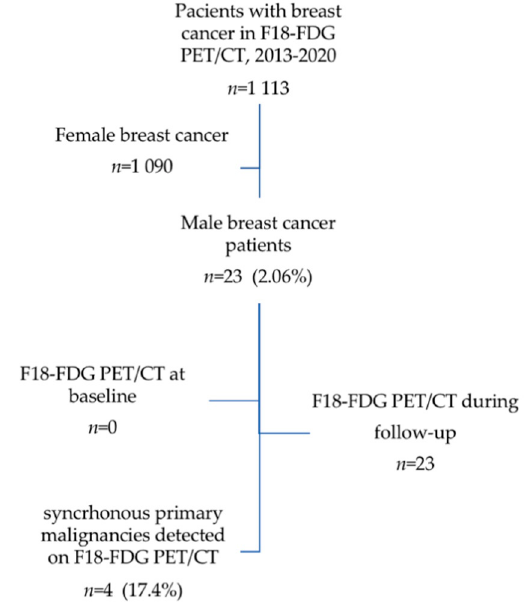
Figure 2. Male breast cancer patients evaluated by F18-FDG PET/CT 2013–2020.